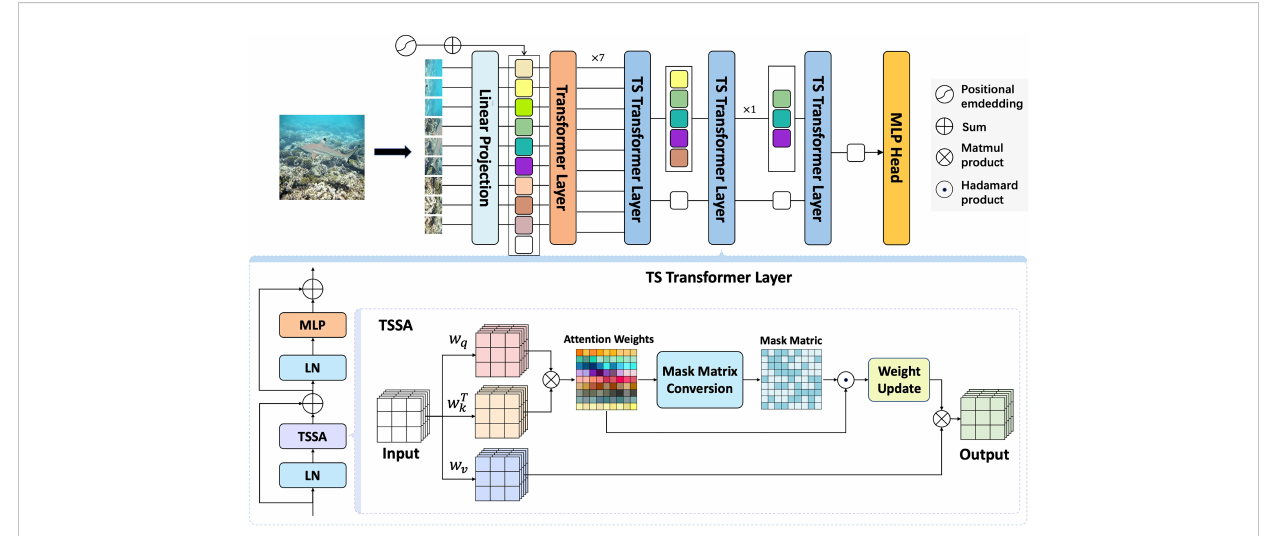
FIGURE 2 The framework of our proposed TSVT and the details of our designed TSSA. An image is fi rst split into a number of patches, each of which is mapped into a feature vector by Linear Projection and combined with learnable position embedding. Contextual links between tokens are then established in the Transformer Layers, and the selection of tokens representing the discriminating regions is performed layer by layer in the latter four TS Transformer Layers with the number of selected tokens in each layer decreasing from the previous layers. In the TS Transformer Layer, TSSA is a sparse selective attention mechanism that generates a mask based on the similarity between tokens so as to limit the attention computation between non-relevant